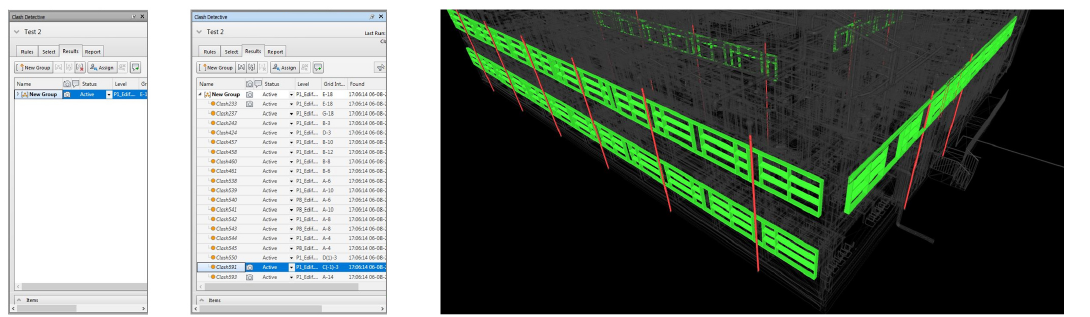
Figure 6. Sunshades intersection of modern building with rainwater